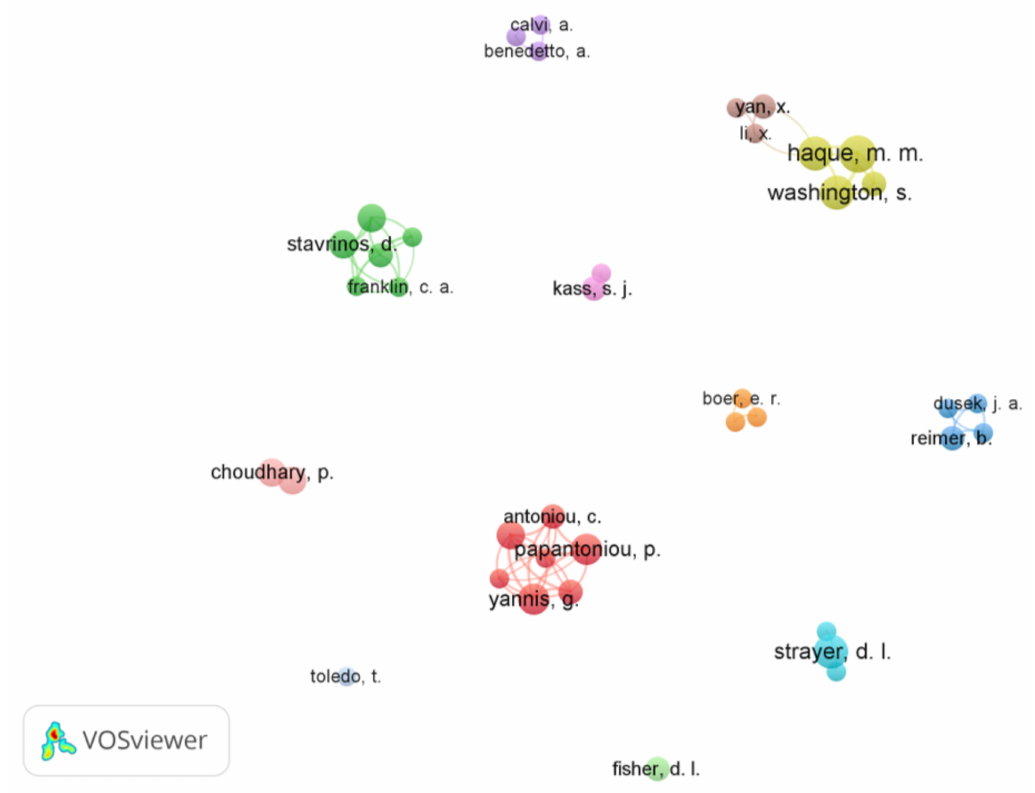
Figure 4. The network of co-authorship; node size indicates the number of papers (used VOSviewer 1.6.16, Leiden University, Leiden, The Netherlands, N =